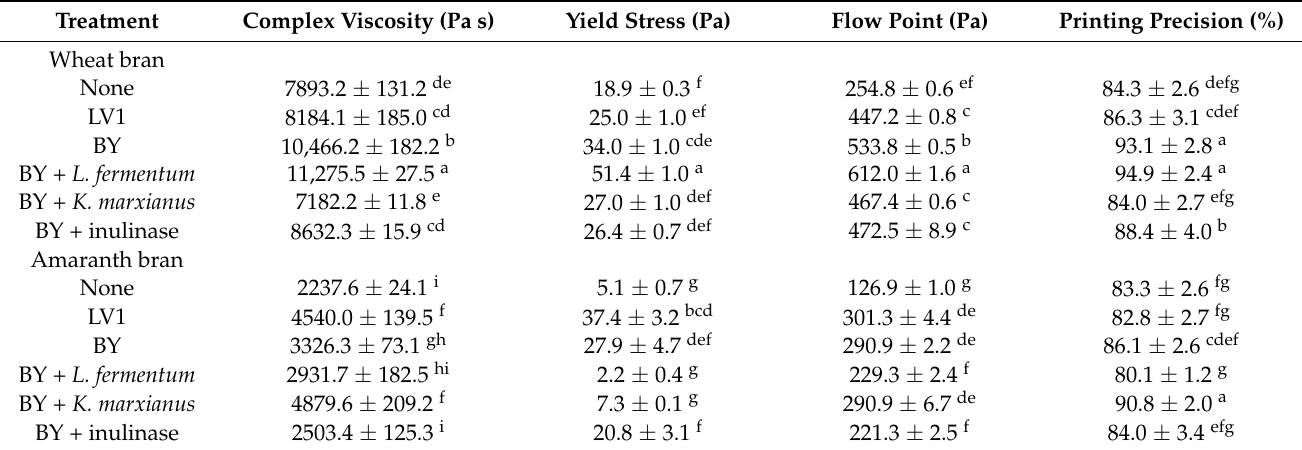
Table 2. Rheological properties and 3D printing precision of the